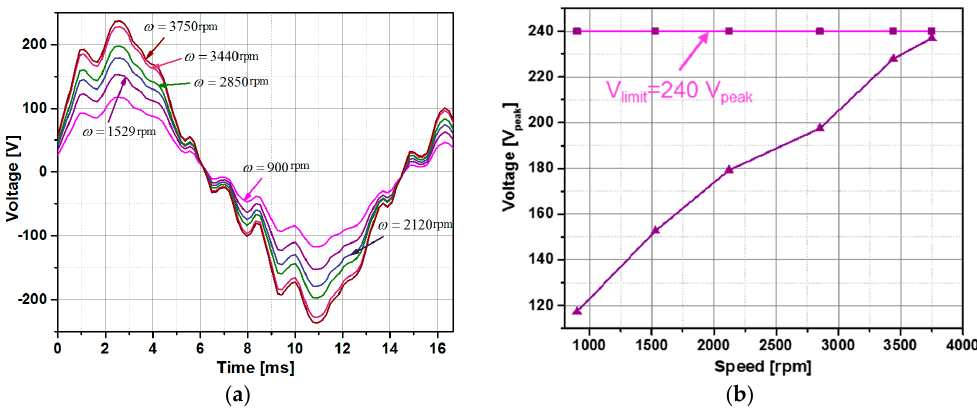
Figure 16. Variation of torque with stator current: ( a ) waveform; and ( b ) average values.